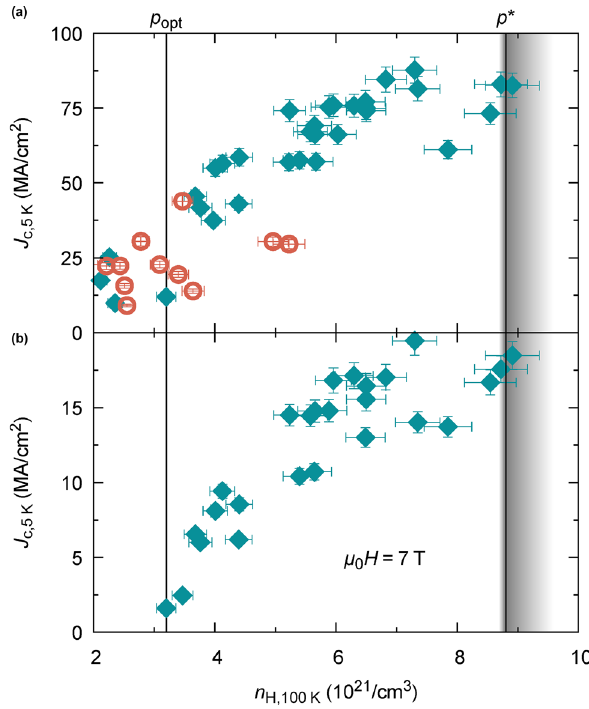
Figure 4. Dependence of J c on charge carrier density: Self-field inductive critical current density, J c , at 5 K versus charge carrier density n H ( 100K ) in ( a ) self-field and ( b ) an applied magnetic field of 7 T of YBCO thin films obtained by CSD (red circles, 250 nm) and PLD (cyan diamonds, 200 nm). The critical current density is determined by SQUID magnetisation measurements. J c is strongly enhanced by increasing the charge carrier density far into the overdoped regime. Optimal and critical doping, p opt and p ∗ , are marked with vertical lines, while the shadowed area around p ∗ indicates the uncertainty of defining the critical doping in terms of n H via Fig. 3. Error bars correspond to uncertainties in film thickness.